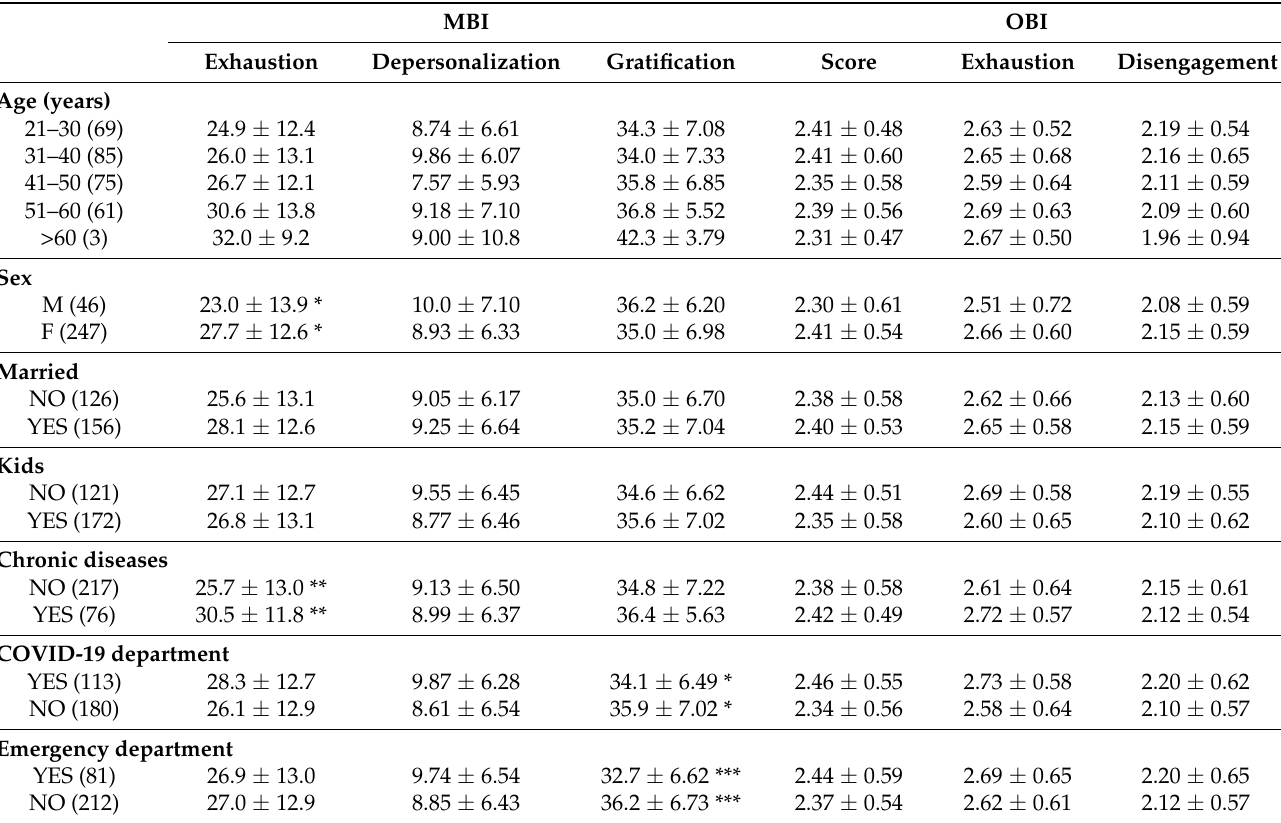
Table 6. Comparison of scores obtained by the Maslach Burnout Inventory (MBI) and the Oldenburg Burnout Inventory (OBI) in participants stratified according to demographic and working